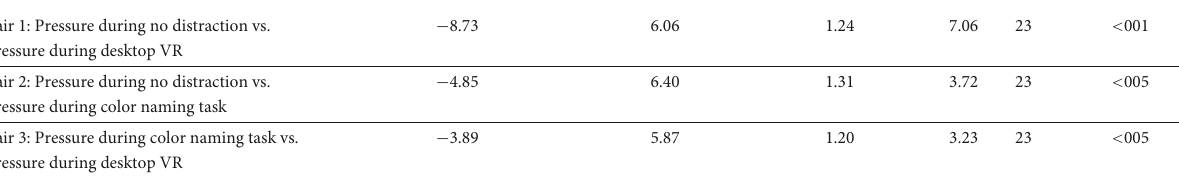
pain (i.e., increased the amount of pressure needed before the healthy